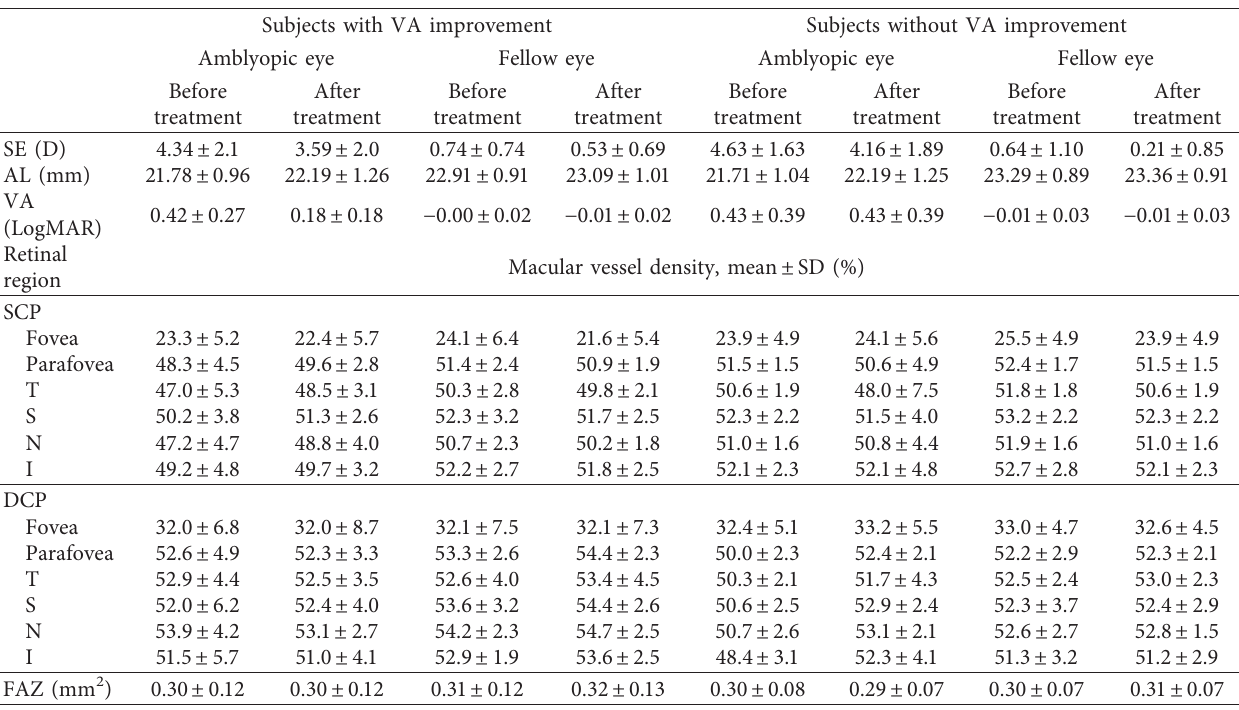
Table 3: Parameters and macular vessel densities in subjects with VA improvement and without VA improvement.